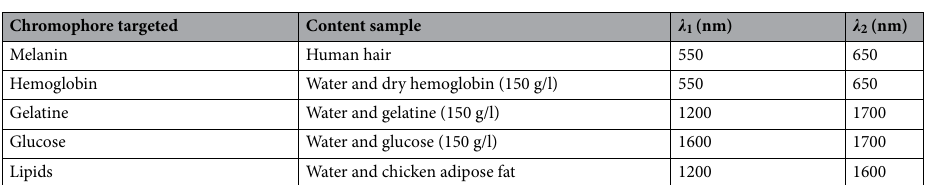
Table 2. Samples created to validate the proposed technique and the wavelengths at which they were sequentially illuminated using OS1 to generate PAM images and subsequently map the chromophores.